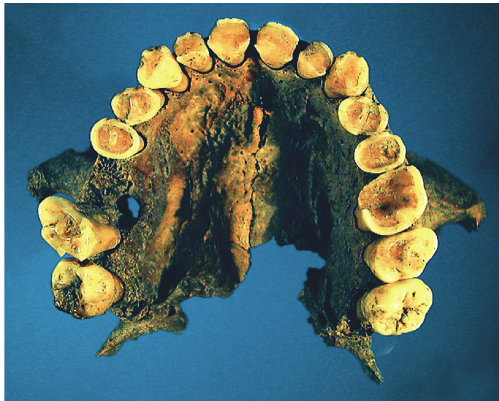
Figure 1: Extensive tooth wear of maxillary teeth in a medieval man estimated to be 35 to 45 years old. The loss of the first right molar was most likely caused by wear penetrating into the pulp subsequently leading to an inflammatory process in the periapical jawbone [6].